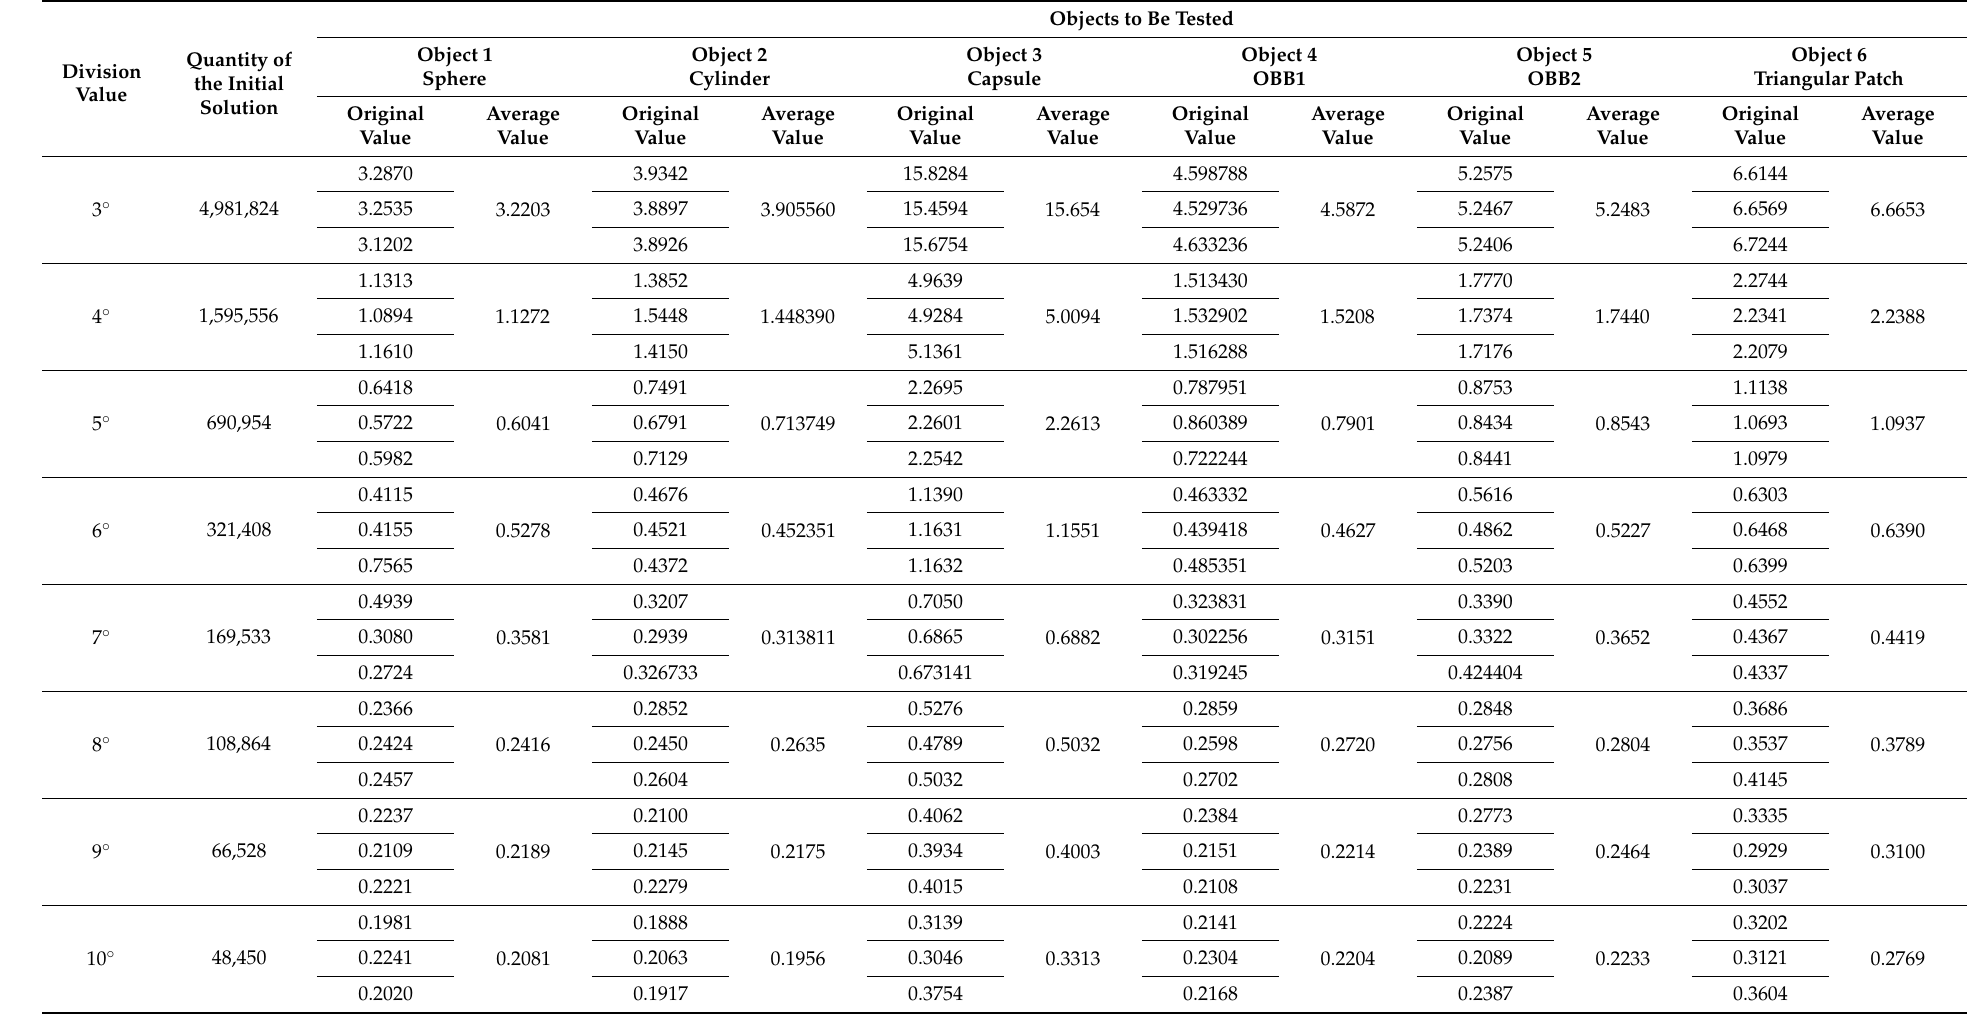
Table A2. Run Time (s) Comparison of Intersection Detection Under Different Division